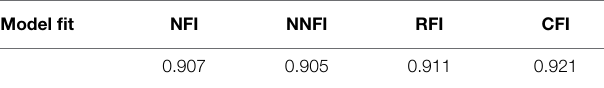
TABLE 5 | Model comparison fit measures.